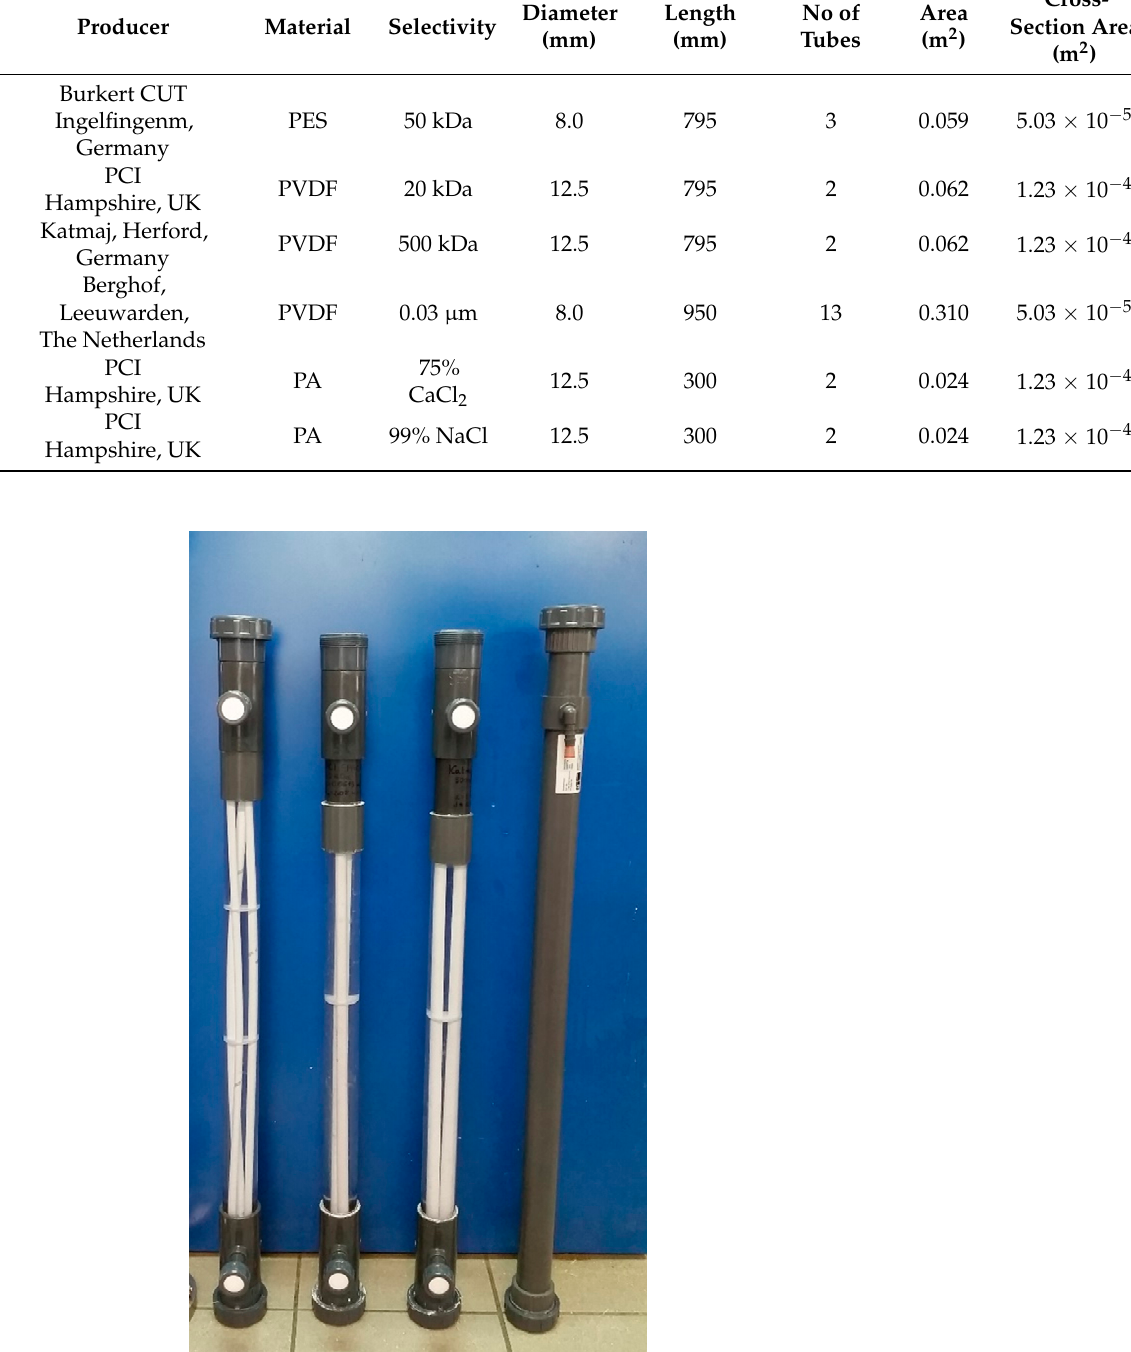
Table 3. The parameters of the membrane modules used during this research.